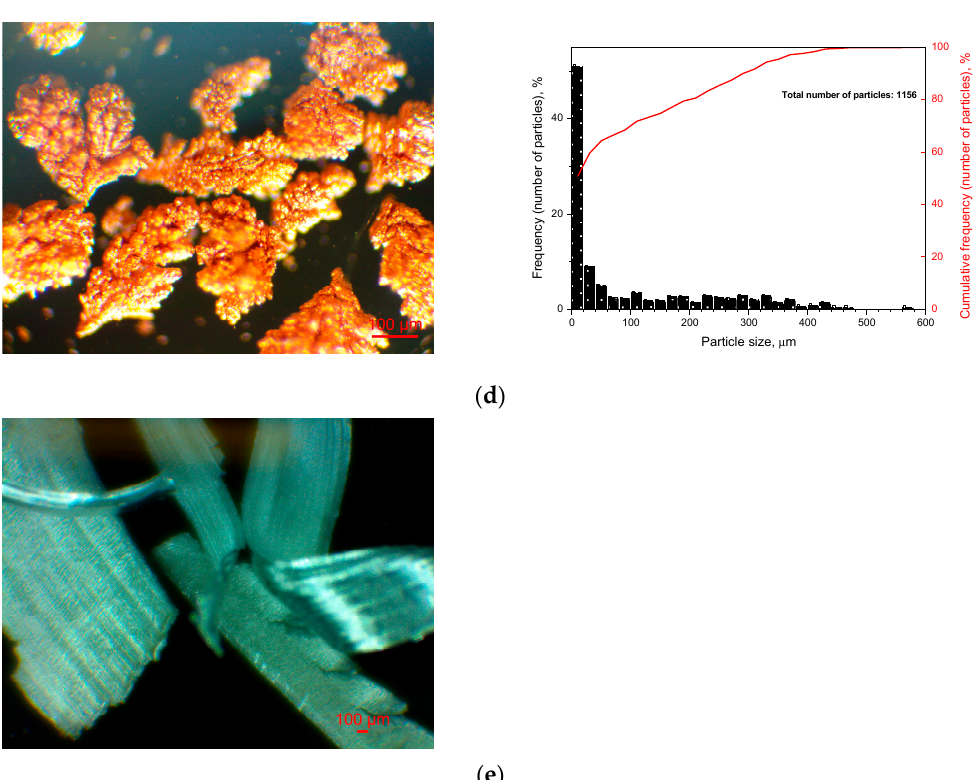
Figure A1. Optical microscope images and particle size distributions for original materials: ( a ) 50–100 nm copper powder; ( b ) 1–19 μ m copper powder; ( c ) 50–70 μ m copper powder; ( d ) 150–250 μ m copper powder; ( e ) original aluminum-based scrap.